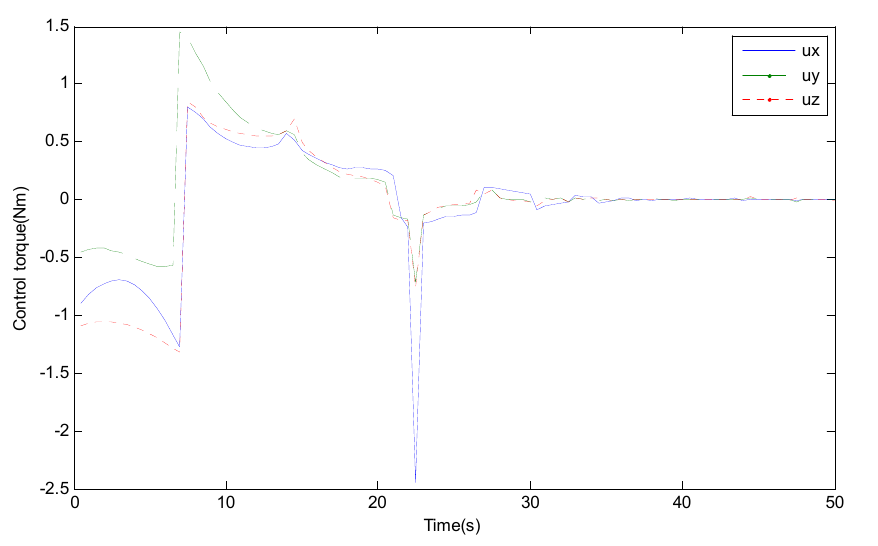
Figure 15. Curve of sliding mode parameter.